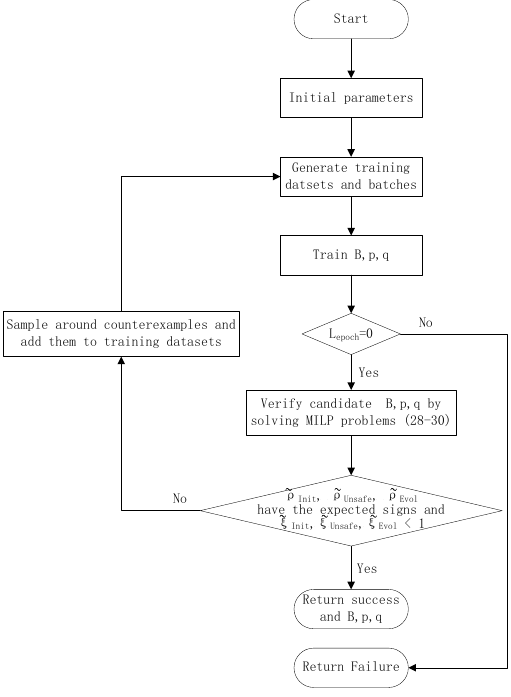
Figure 2. The flowchart of Algorithm